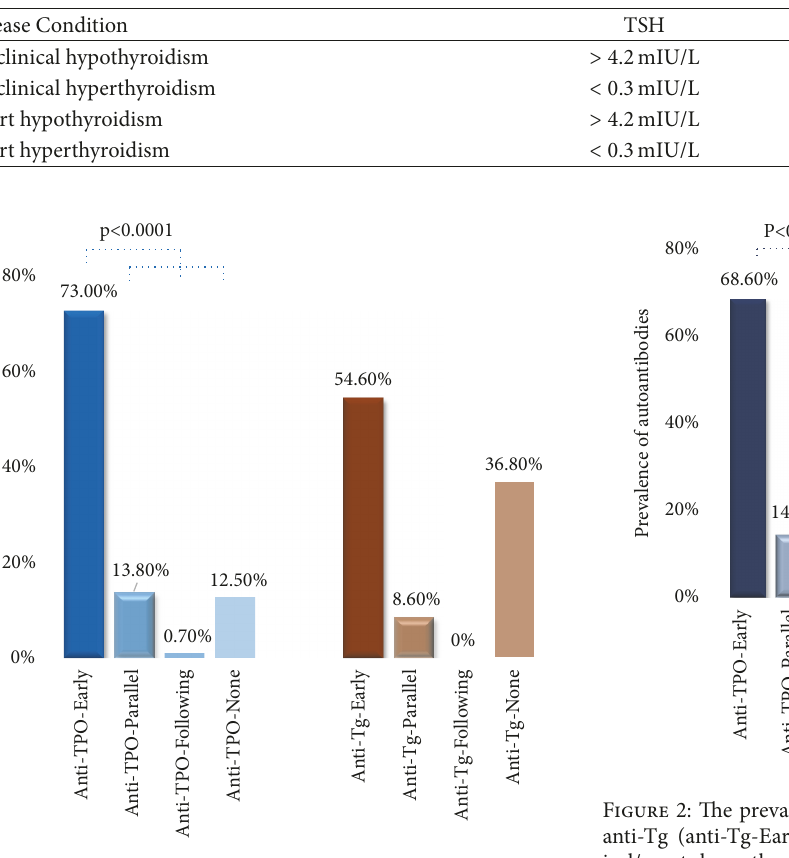
Figure 1: The prevalence of anti-TPO (anti-TPO-Early, blue) and anti-Tg(anti-Tg-Early,orange)priortotheonsetofsubclinical/overt hypothyroidism compared to the combined control groups. Anti- TPO combined control group (blue) consists of anti-TPO-Parallel, anti-TPO-Following, and anti-TPO-None. Anti-Tg combined con- trol group (orange) consists of anti-Tg-Parallel, anti-Tg-Following, and anti-Tg-None.